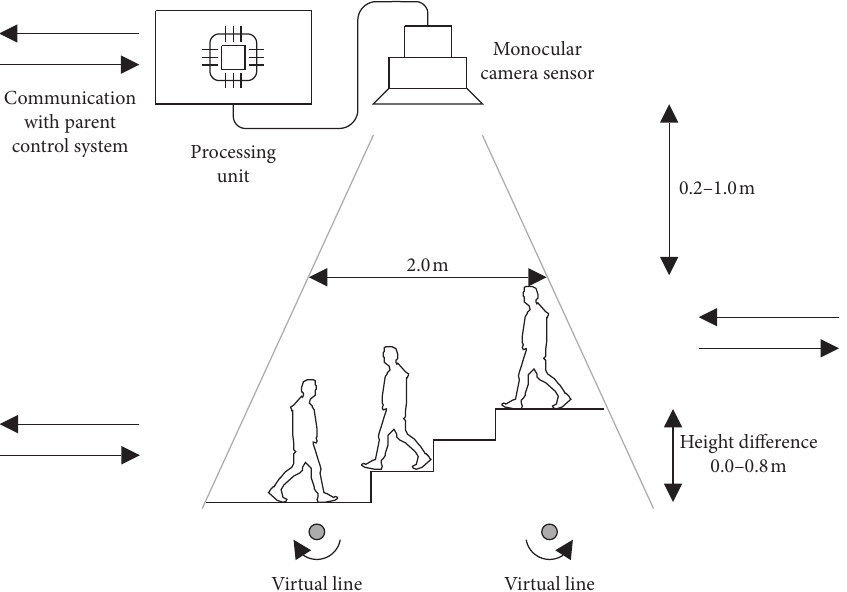
Figure 4: Architecture of person flow monitoring system (side view). Crossing space between lines causes person to be